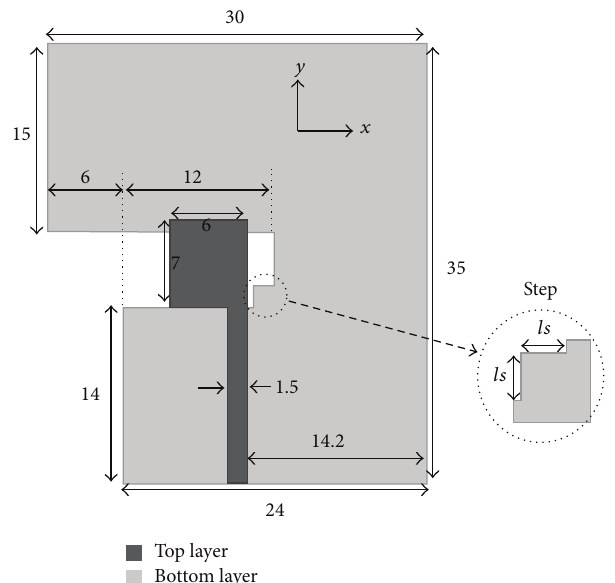
Figure 1: Geometry of the proposed antenna (all the geometrical dimensions are expressed in millimeter).